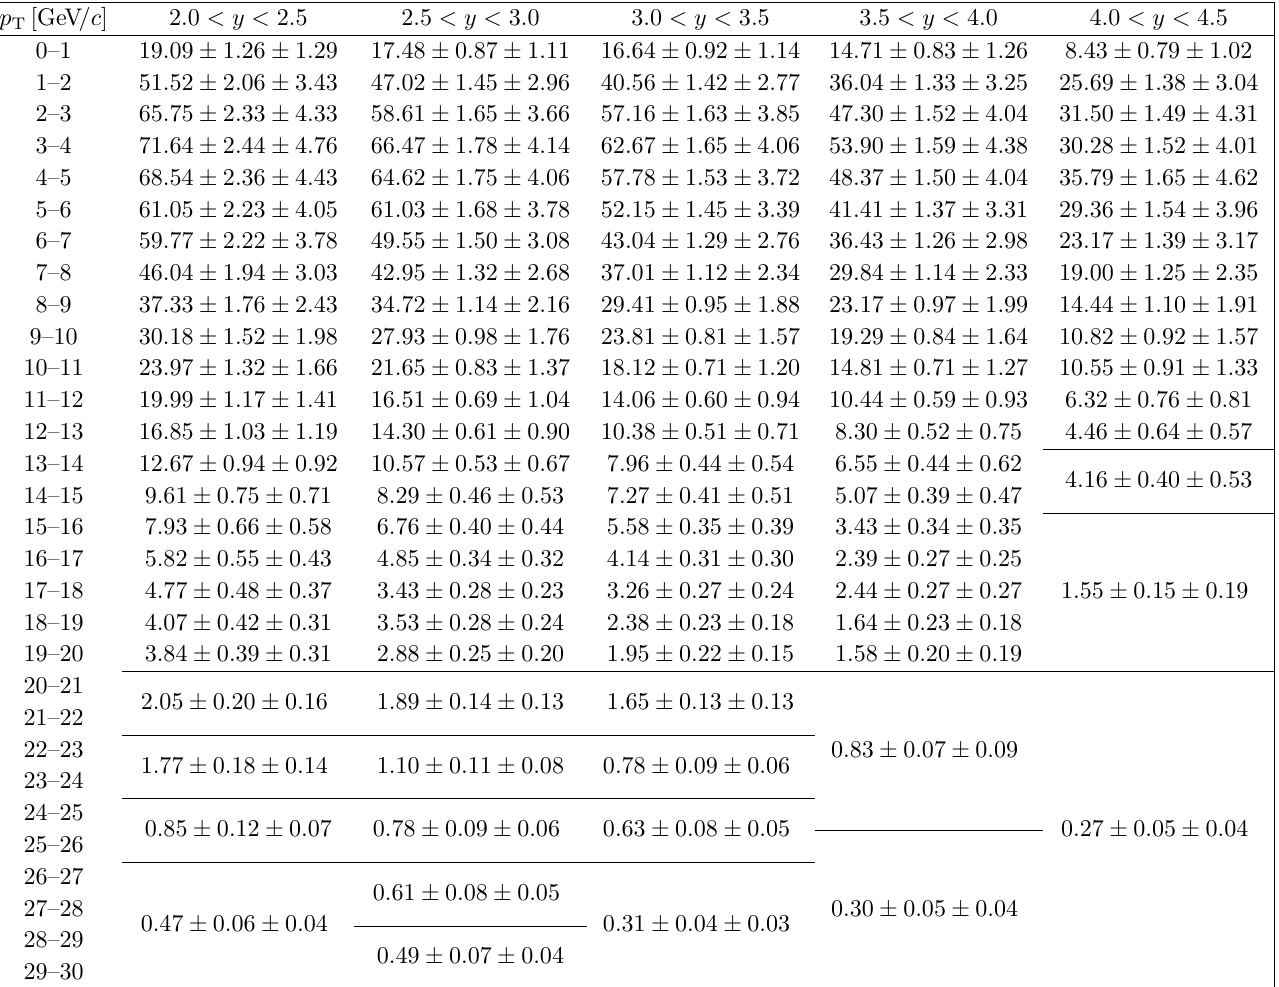
Table 3 . Double-di(cid:11)erential cross-sections times dimuon branching fraction in di(cid:11)erent bins of p T and y for (cid:7) (2 S ) (in pb). The (cid:12)rst uncertainty is statistical and the second is systematic.